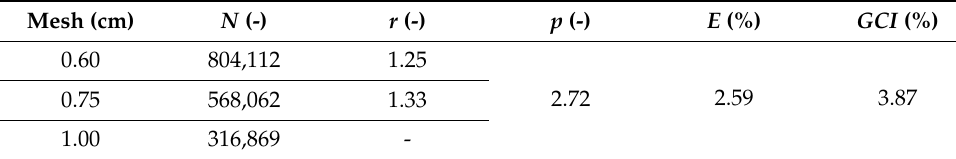
Table 4. GCI (grid convergence index)